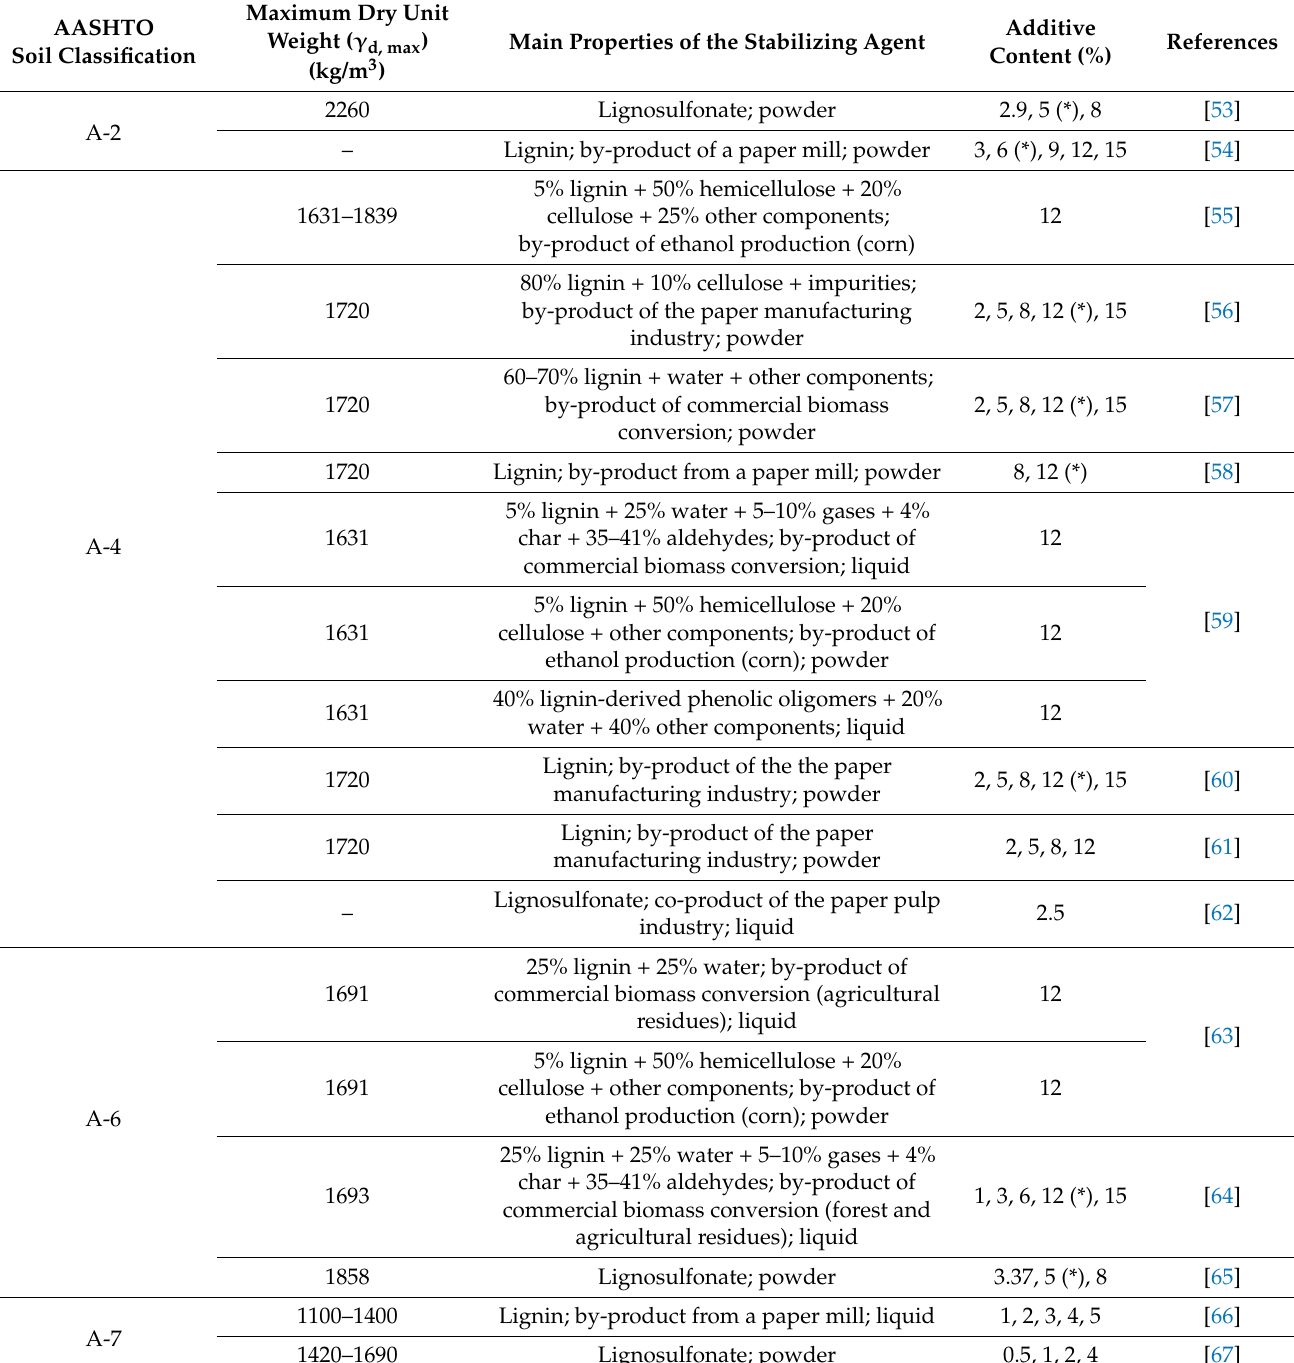
Table 1. A review of studies concerning the application of lignin as a stabilizing agent for soil subgrade in road construction. AASHTO Soil